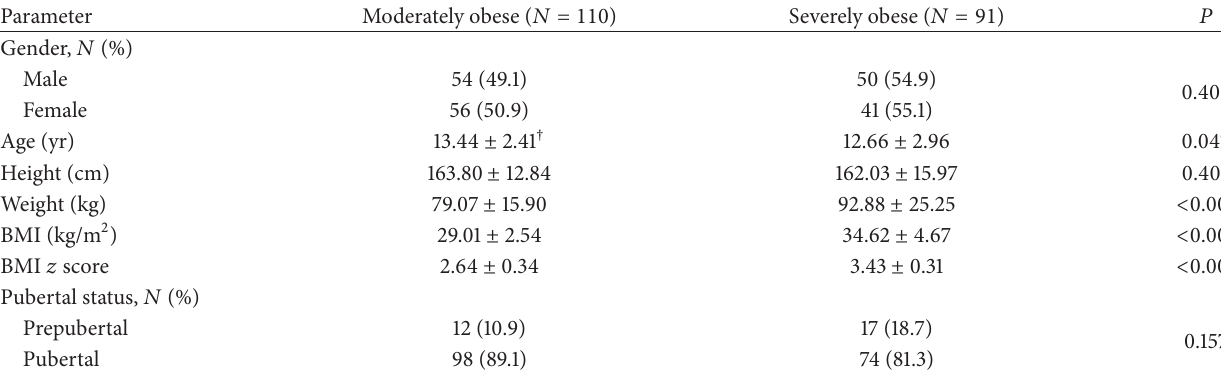
Table 1: Baseline anthropometric characteristics of subjects enrolled in the study ∗ .